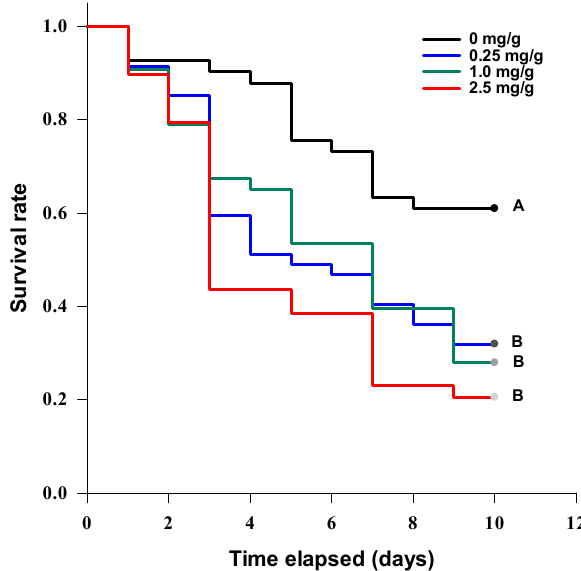
Figure 10. The survival curves of Acheta domesticus adults at different concentrations of tenuazonic acid added to the feed. The curves marked with one letter did not differ significantly at p = 0.05 by log-rank test with Holm–Sidak adjustment.